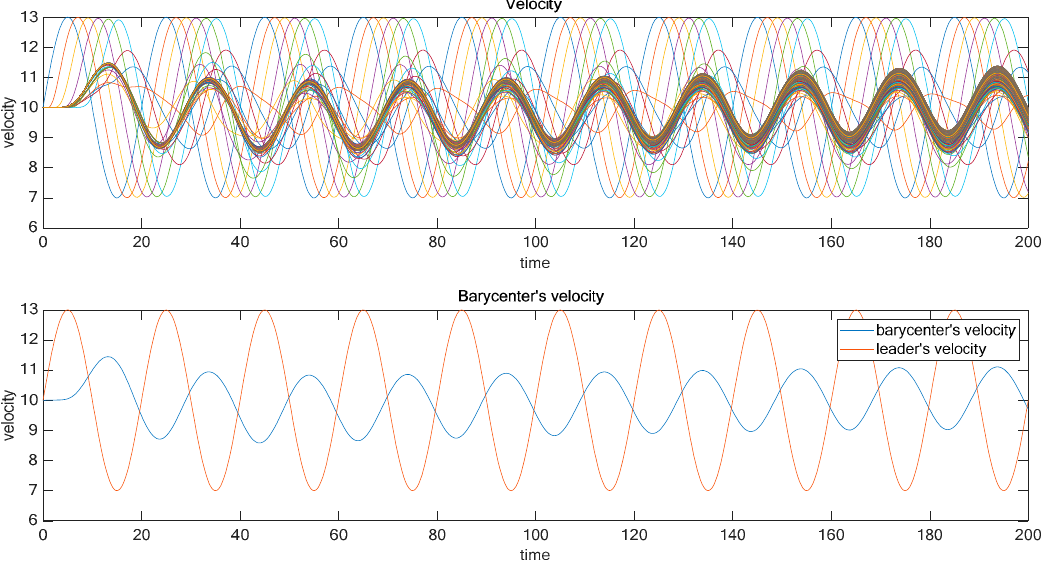
Figure 15. The small-world model simulated with b = 20 m and excited by the harmonic perturbation of the Leader’s velocity Equation (14); symbolism is the same in Figure 11.